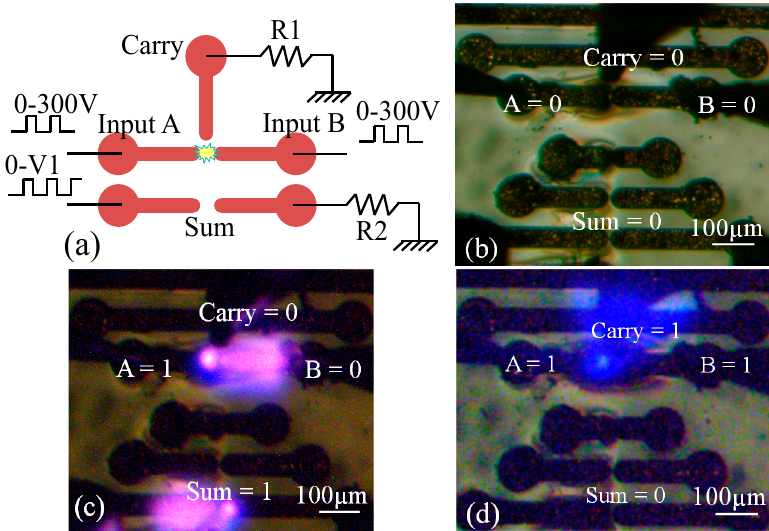
Figure 16. ( a ) Schematic representation of the electrode setup for 1-bit half-adder. State of the Sum and Carry bits are represented by plasma on their corresponding electrodes for the input states (A, B = 0), (A = 1, B = 0) and (A, B = 1) in ( b – d ), respectively. All figures are reproduced from [35].